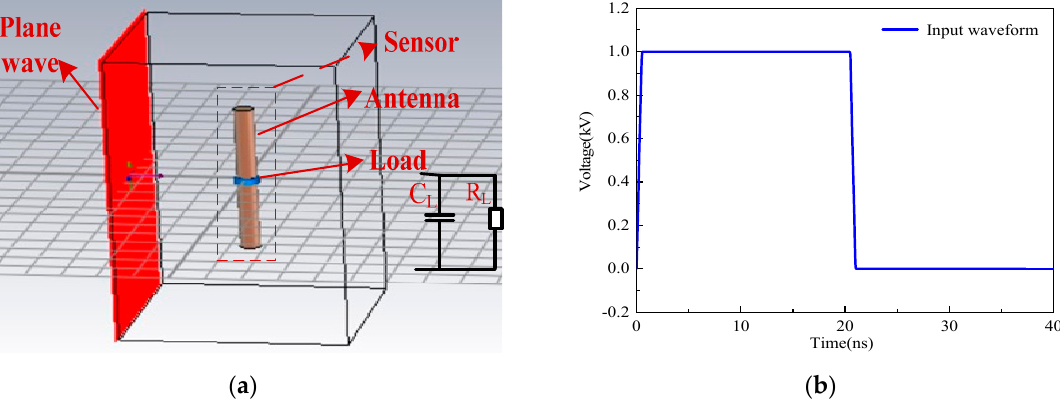
Figure 8. The simulation model of optical-fiber EMP field measurement system ( a ) and the input EMP field waveform ( b ).